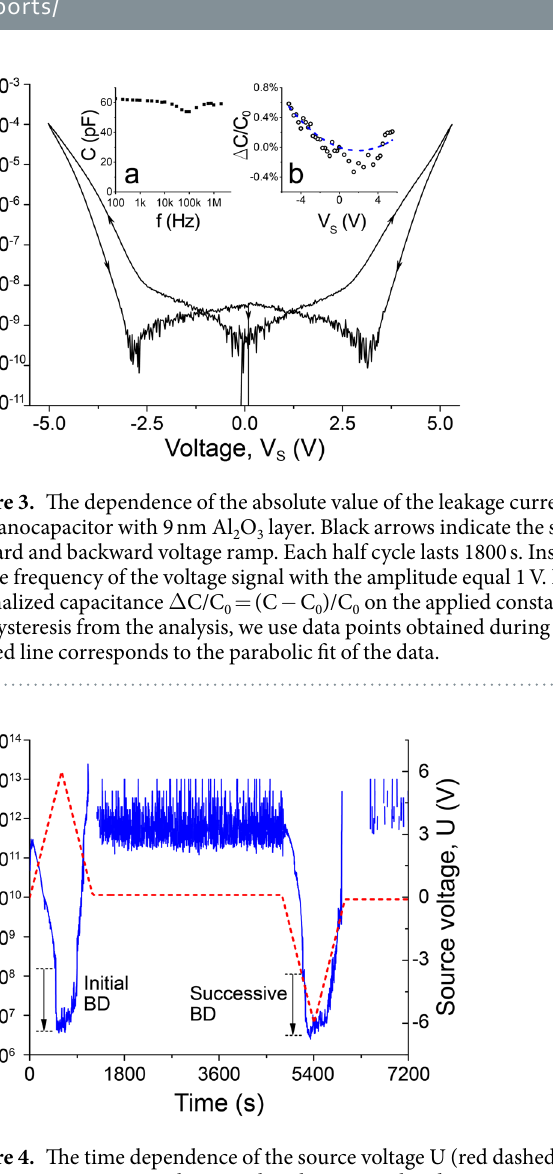
Figure 4. The time dependence of the source voltage U (red dashed line) and sample resistance R s (blue line) for the nanocapacitor with 4 nm Al 2 O 3 layer. Initial and successive global breakdown jumps are marked with black